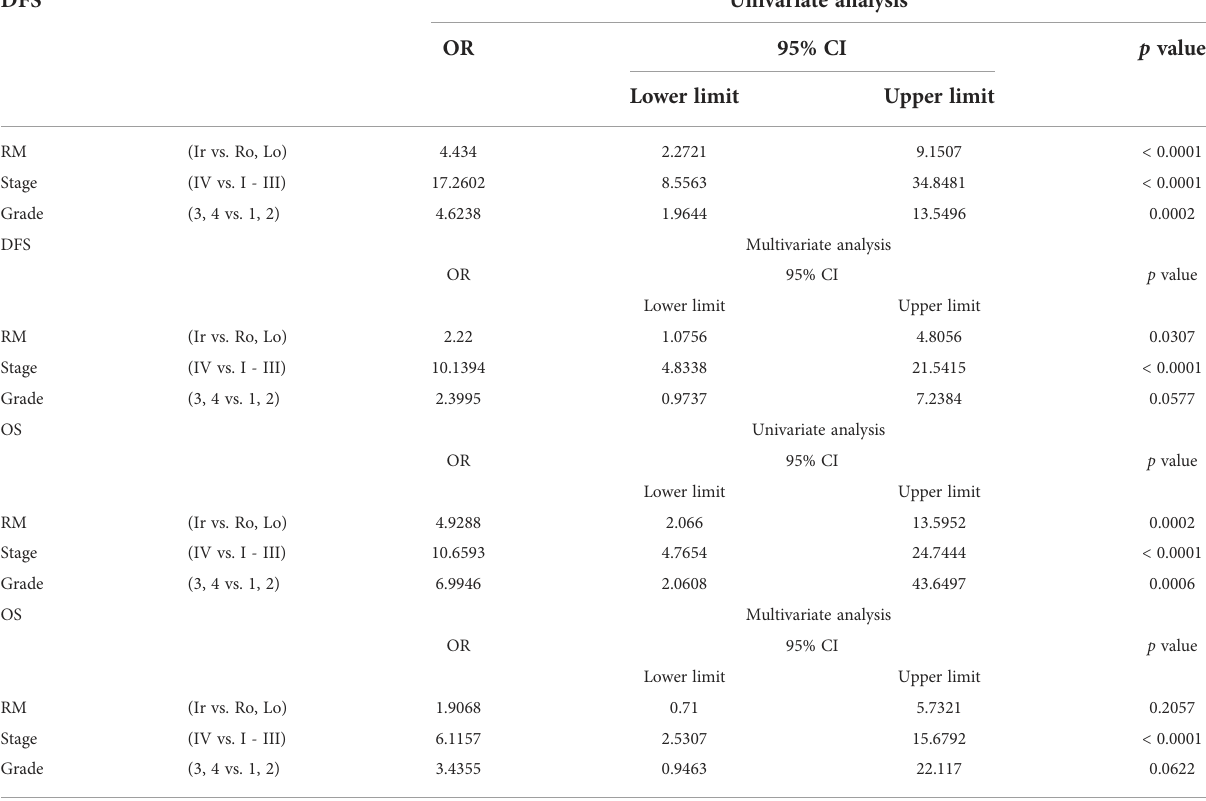
TABLE 2 Univariate and multivariate analyses of different parameters for disease-free survival (DFS) and overall survival